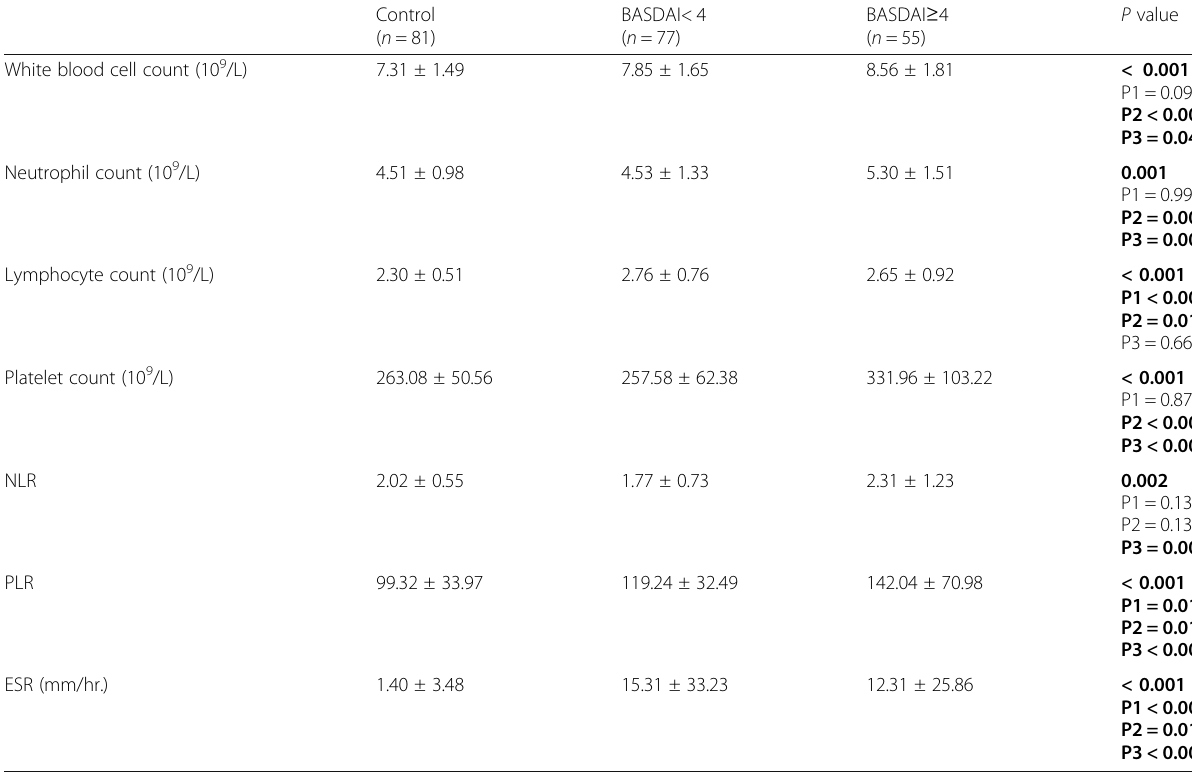
Table 2 Laboratory parameters of study groups based on disease activity